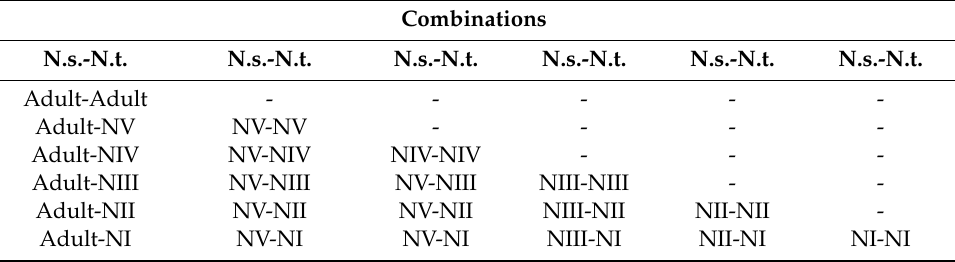
Table A2. Combinations used in the IGP N. pseudoferus – N. tenuis , assay 1, under laboratory conditions and without alternative prey, when both predatory species are in the same or lower stage class.